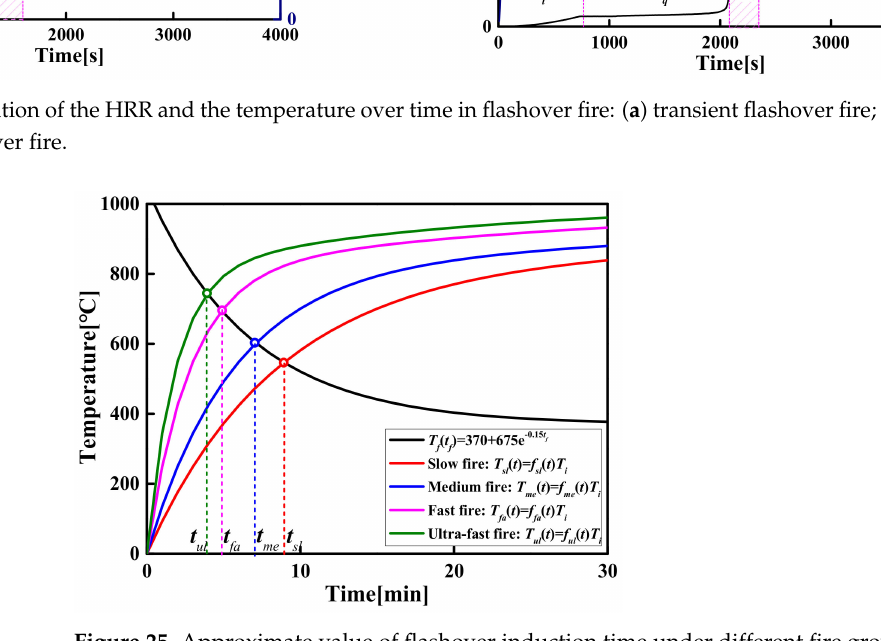
Figure 25. Approximate value of flashover induction time under different fire growth